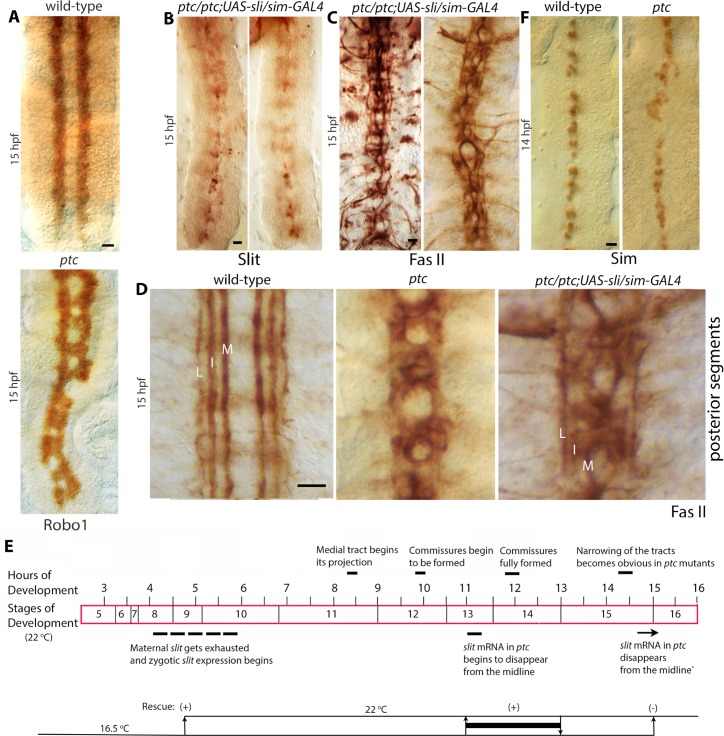
Expression of the slit gene in the midline in ptc mutants rescues the funneling phenotype.(A): The abundance of Robo1 is not affected in ptc embryos. Wild-type and ptc mutant embryos were stained for the expression of Robo1. The abundance of Robo1 is unaffected in longitudinal tracts in 15 hpf ptc mutant embryos. The presence of Robo in commissures in ptc is due to the inappropriate midline crossing of Robo-positive longitudinal tracts and not from commissural tracts. Scale bar: 8 μm. (B, C, D): ptc mutant embryos transiently expressing slit at the midline between 11 and 13 hours of development from a UAS-slit transgene driven by the midline driver sim-GAL4 were stained for Slit (B) and Fas II (C, D). These panels show that the transient midline expression of slit restores Slit in the midline and in tracts, albeit at a lower concentration (B), and rescues the funneling phenotype (B-C). It also improves the fasciculation of longitudinal tracts compared to non-rescued ptc embryos (D), although it is possible that this improvement in fasciculation is contributed by the widening of the tracts in rescue embryos. Note that the midline crossing of the medial tract in ptc is slit-independent and expected to be present in rescued embryos. Scale bar: 8 μm. (E): Developmental stages/time, with key axonal guidance events (upper) and temperature shifts of ptc/ptc; UAS-slit/sim-GAL4 embryos (lower). Maternal slit gets exhausted and zygotic slit transcription begins between 4–6 hours of development [7]. The (+), or the (-) signs indicate rescue/no rescue in corresponding upshifts. The thick bar between 11–13 hpf of development corresponds to the period just as endogenous slit expression begins to decay in the posterior region. It also indicates the rescue effect by the expression of the slit gene between these two time points. (F): Wild-type and ptc mutant embryos were stained with an antibody against Sim. Note that even at 15 hpf Sim expression is mostly unaffected with only disorganization of cells and gaps along the midline. The distance between L-L tracts across the midline (in μm with standard deviation) with Fas II staining in rescued embryos are as follows: anterior region: 26+/-0.9; posterior region: 26.8+/-1.0. N = 6 embryos per set. The difference in the distance between tracts in the rescued embryos to wild-type was not statistically significant, but it was in the posterior end between the rescued and ptc mutant embryos (P<0.001, student t-test). This indicates a rescue of the narrowing of tracts in ptc mutant embryos with the transient expression of slit at the midline. DAB-histochemistry was used for color development of embryo staining. Scale bar: 8 μm.